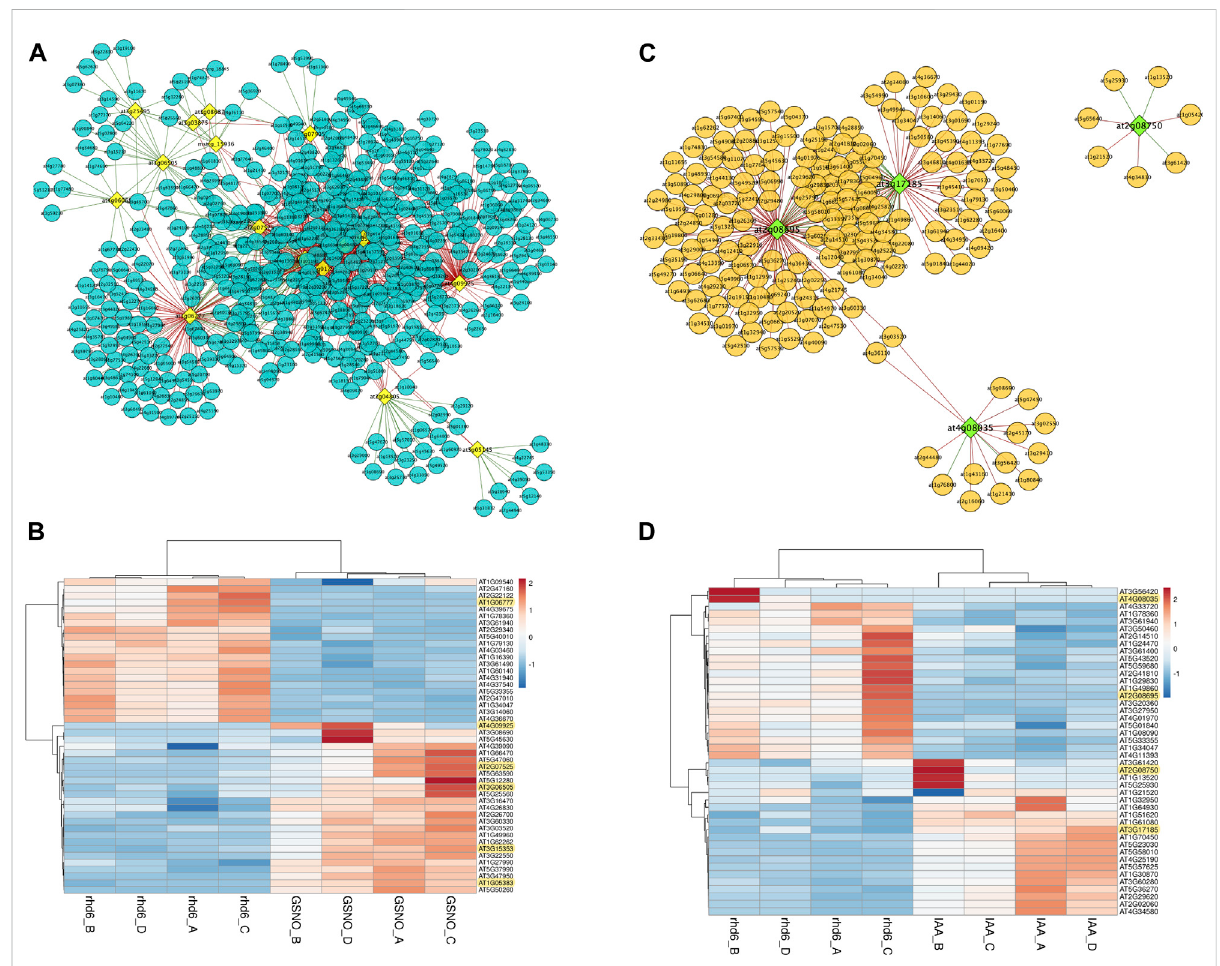
Results from co-expression analysis between differentially expressed (DE) long noncoding RNAs (DElncRNA) and differentially expressed protein-codinggenes(PCGs). (A) Co-expressionnetworkgeneratedforDElncRNAandDEPCGswhichpresentsimilarexpressionpatternsforGSNO treatment. The DElncRNA are represented in yellow and the DE PCG in blue. The lines represent the connections (edges) among DElncRNA and DE PCGs pairs, which may be correlated (green) or anticorrelated (red). (B) Heatmap showing the top 10 most correlated and anticorrelated PCGs and how they vary their expression patterns in the same or opposite direction to DElncRNAs, which are highlighted in yellow. All DElncRNA in the fi gurearecorrelatedwithDEPCG,exceptforAT1G06777. (C) IAAtreatmentco-expressionnetwork.TheDElncRNAarerepresentedingreenandthe DEPCGarerepresentedinorange.Greenlinesrepresentcorrelatedgenepairs,whileredlinesareanticorrelatedgenepairs. (D) Top10heatmapwith themostcorrelated andanticorrelatedPCGs,and DElncRNAs arehighlighted inyellow. AT2G08695 and AT4G08035 DElncRNAs are anticorrelated, while DEmRNA AT3G17185 and AT2G08750 are correlated. In Figures (B,D) , the respective color keys in the right side represent the